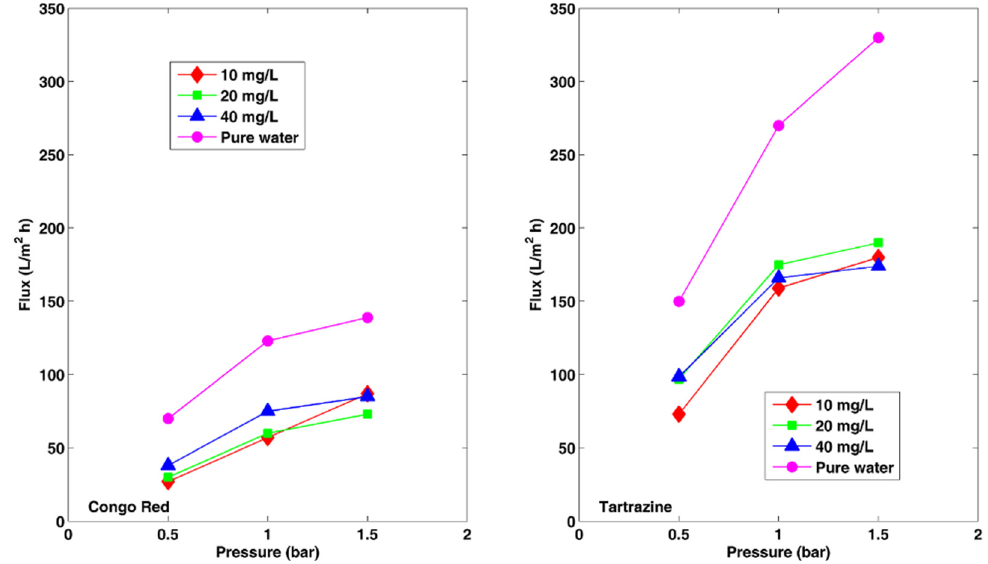
Figure 8. Effect of pressure on permeate flux of pure water and aqueous solutions of Congo Red and Tartrazine through the photocatalytic membrane.